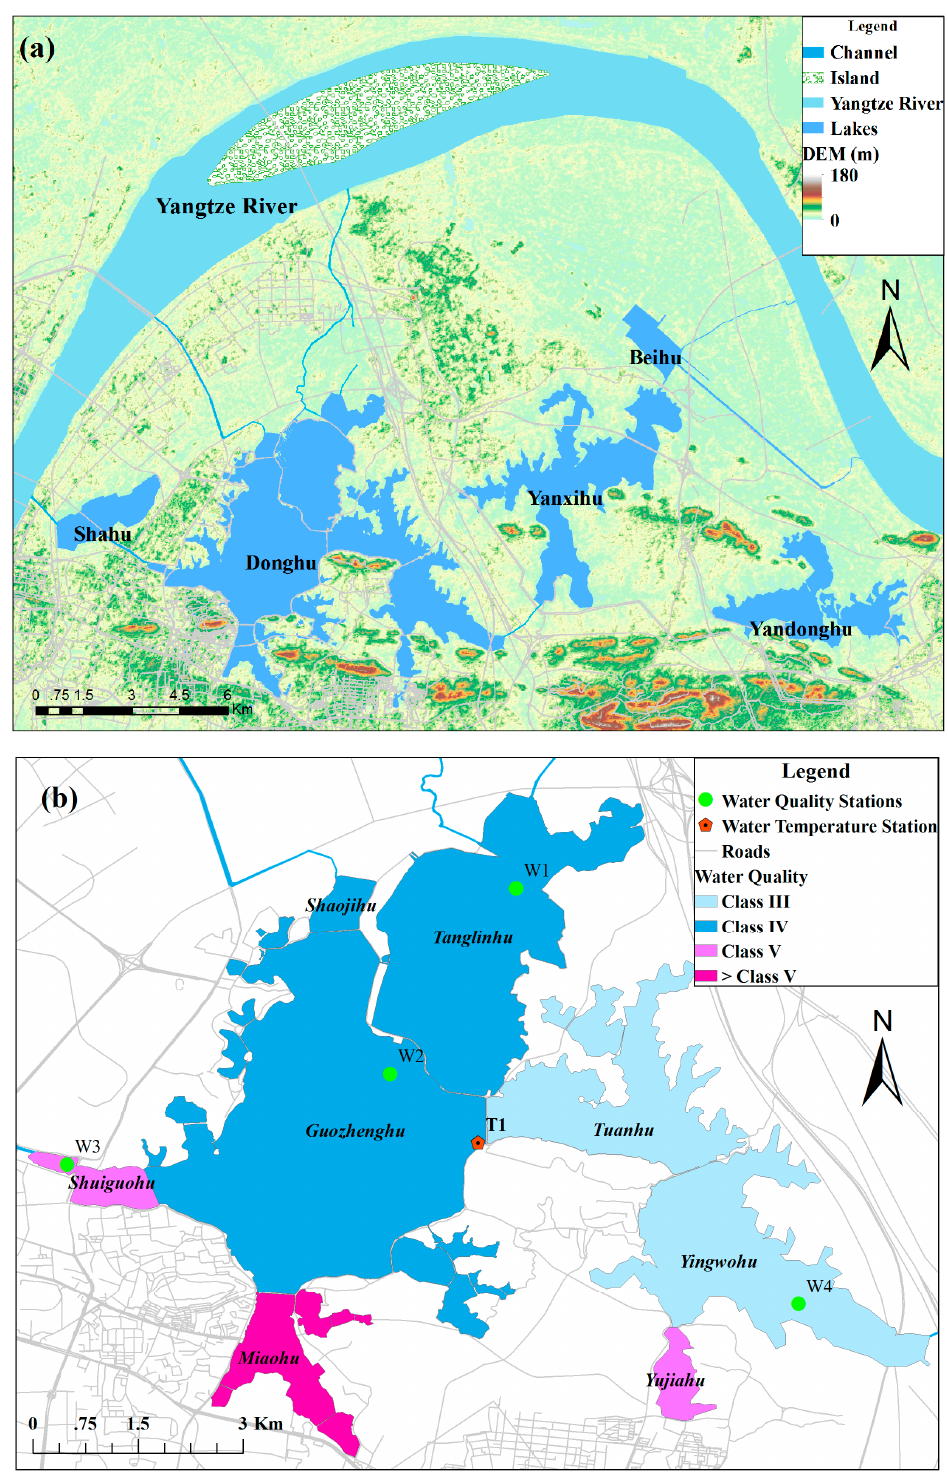
Figure 6. The study area: ( a ) Lake Donghu and its surrounding urban lakes; and ( b ) water quality in Lake Donghu in May 2011.